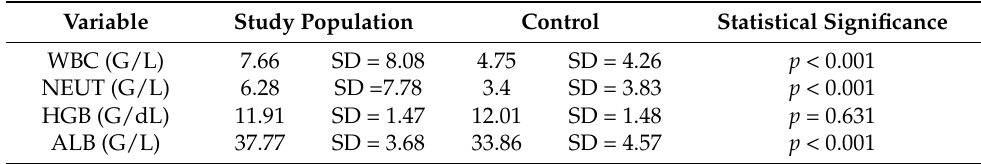
Table 2. Levels of laboratory markers of nutritional status after CRT/BRT ( n =